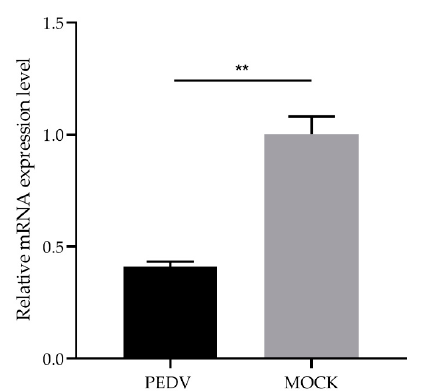
Figure 3. Expression changes of the GLP-2 gene in PEDV-infected IPEC-J2 cells. ** p < 0.01. Bars represent the mean ± SD ( n = 3).